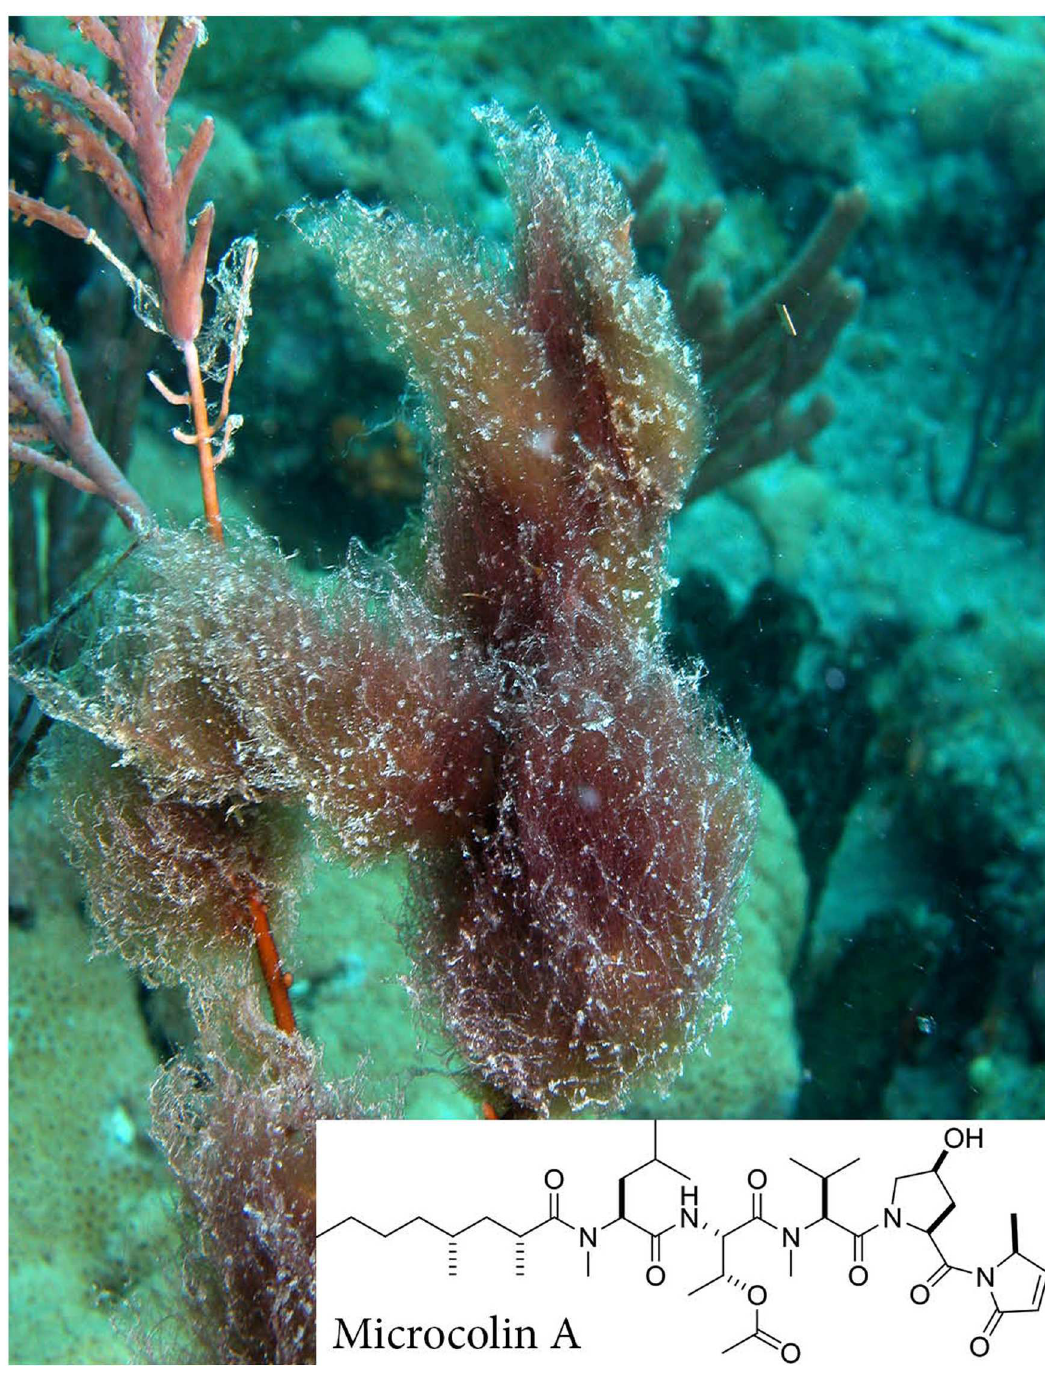
Fig 1. An in situ photograph of Okeania erythroflocculosa collected from southern Florida reefs, with the structure of microcolin A inset.